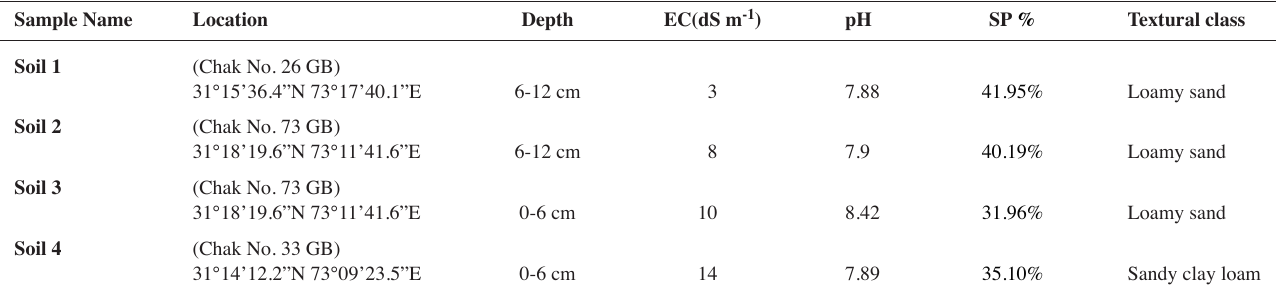
Tab. 1: Location, depth, EC, pH, SP% and textural class of the collected soil samples from district Faisalabad, Pakistan (n =